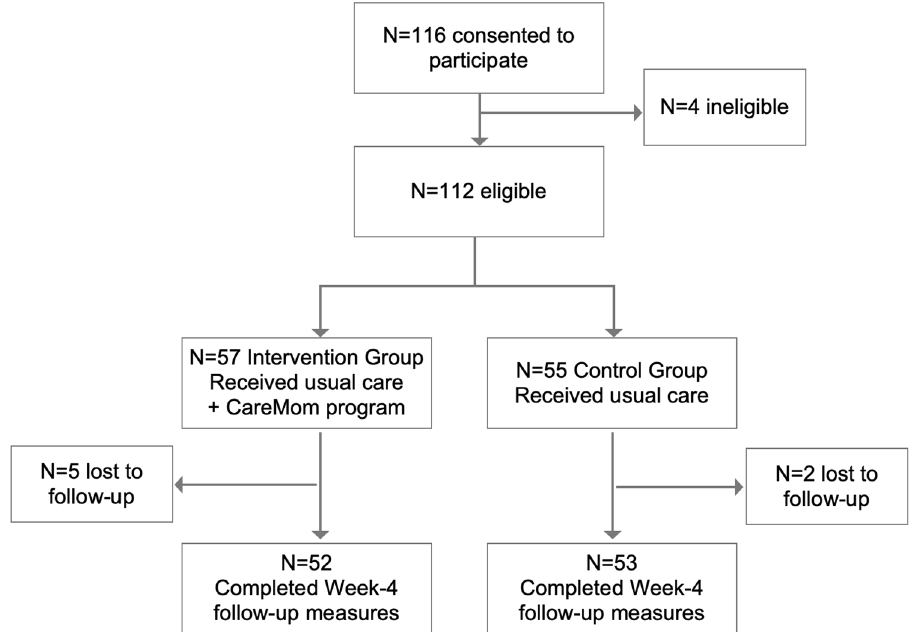
Figure 4. Participant recruitment flow.